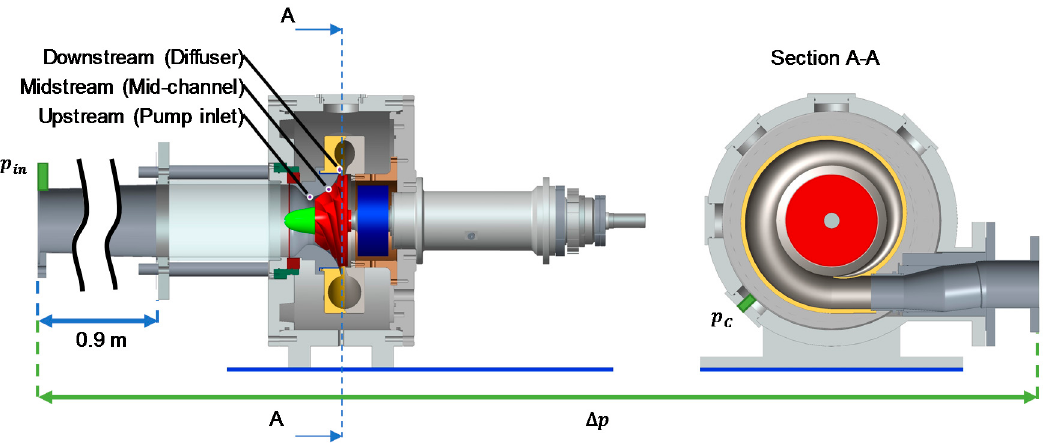
Figure 2. VAMPUFF pump test setup.